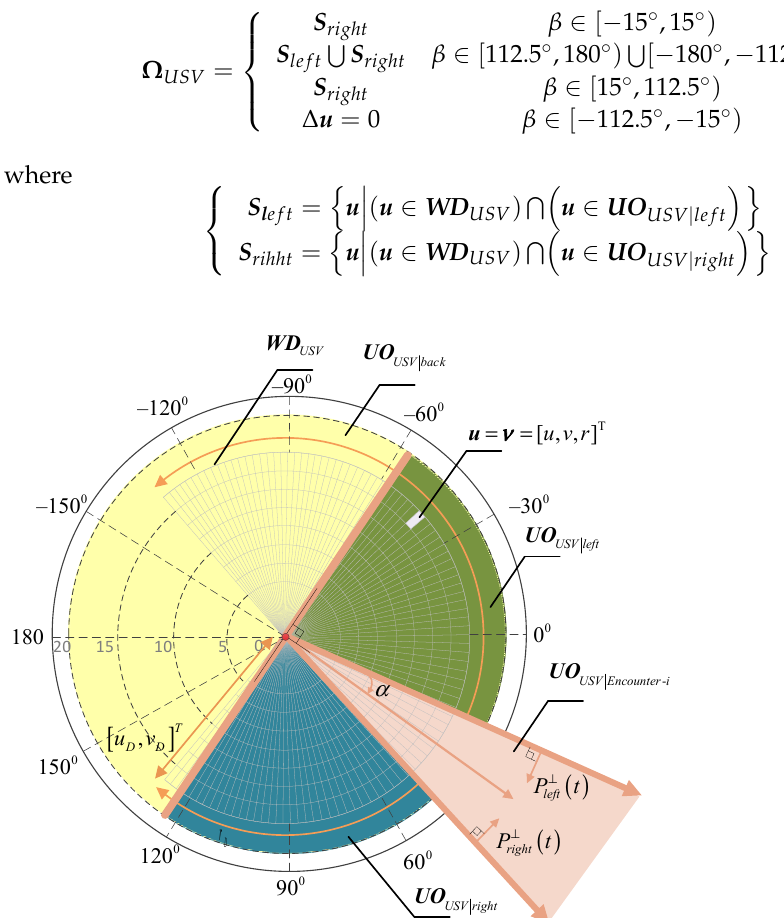
Figure 7. Multi-vessel encounters collision detection model.